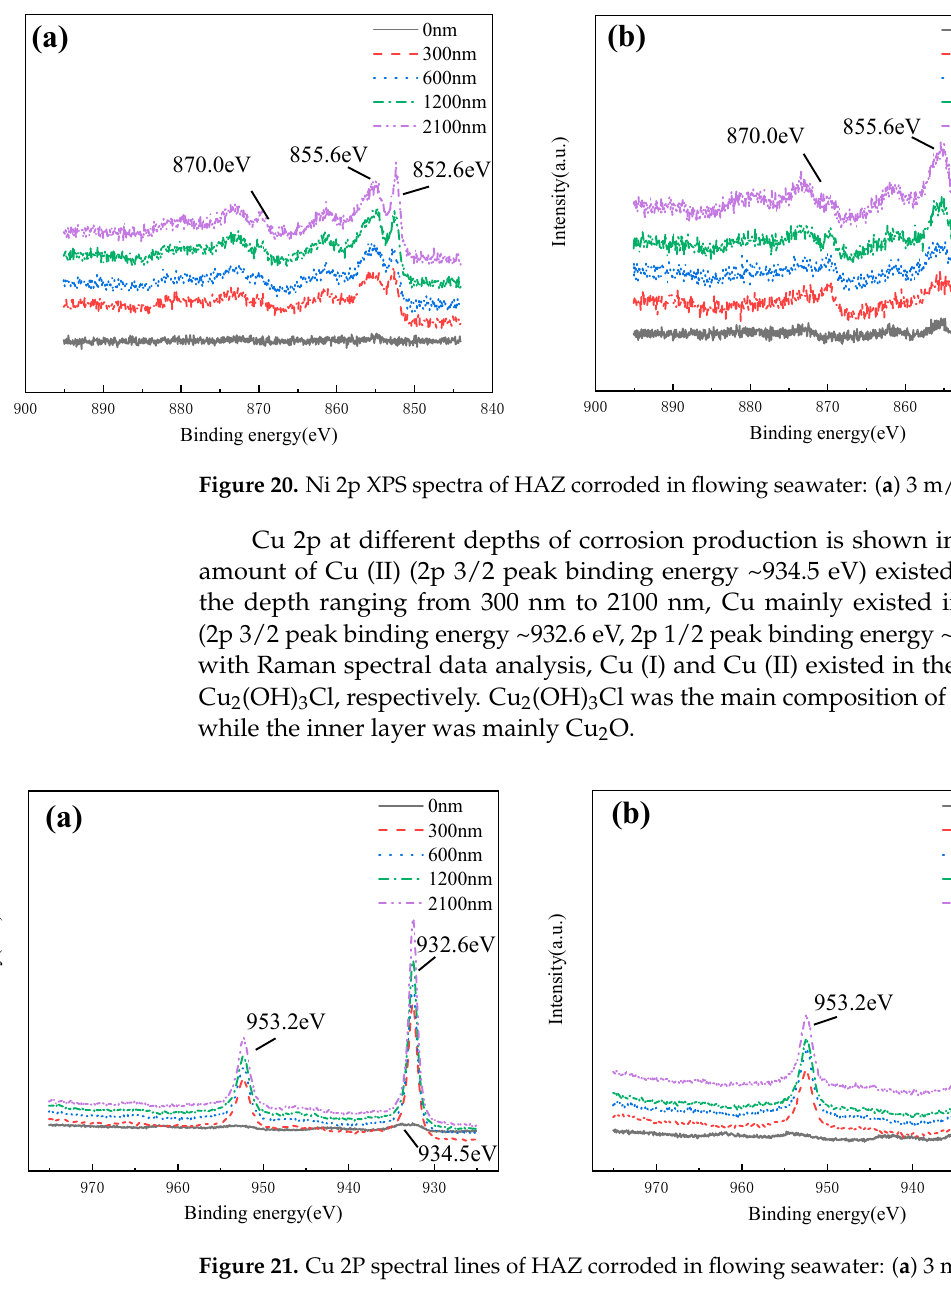
element existed in the form of Ni and Ni(II) in the inner layer. Combined with the analysis of Raman spectral data, Ni(II) existed in the form of NiO.